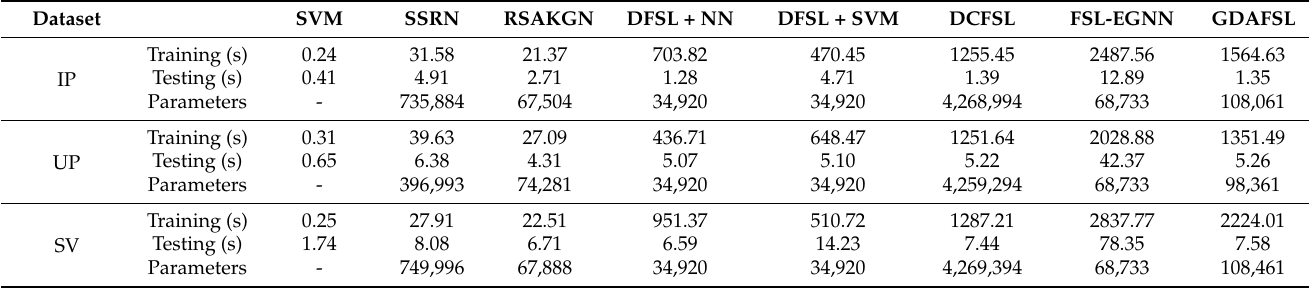
Table 10. Training Time, Testing Time, and Parameters of Different HSI Classification Methods on Three Target Datasets.